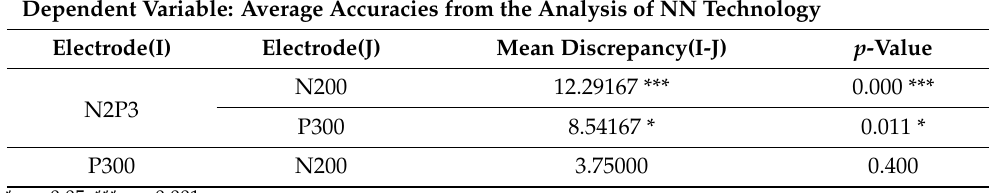
Table 9. Multiple comparison of the average accuracies calculated by the NN technology.